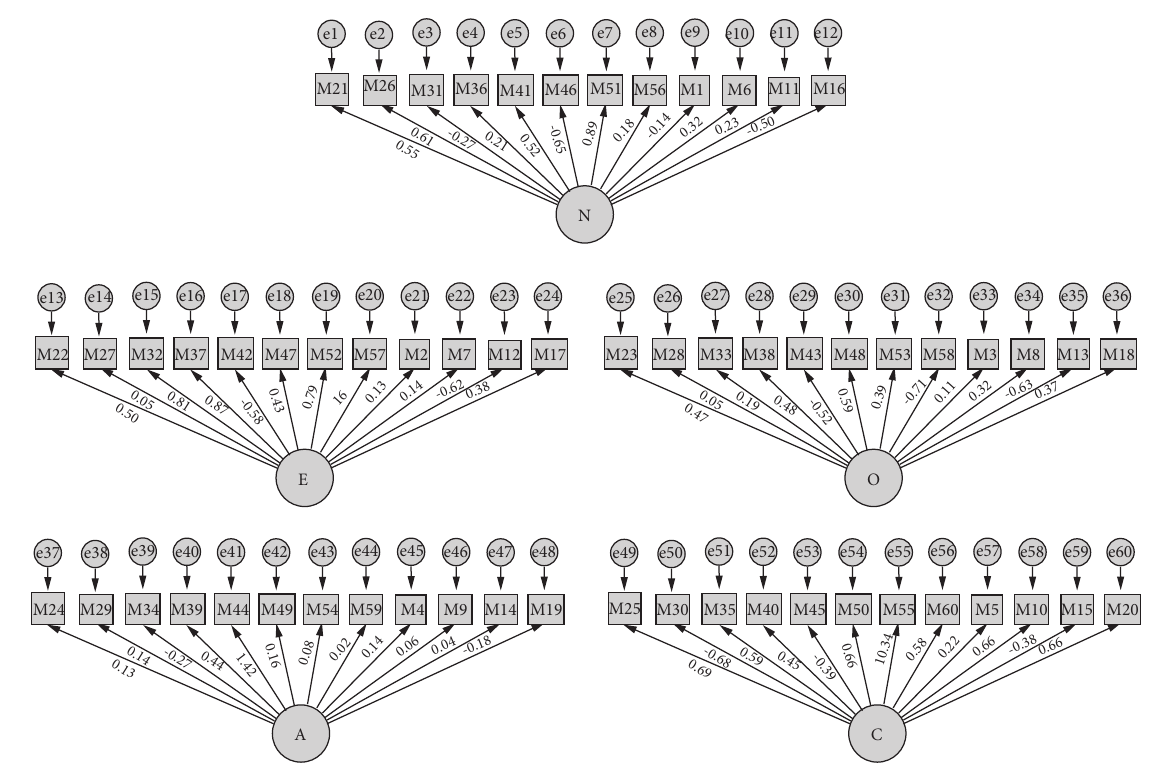
Figure 8: The confirmatory factor analysis structure.